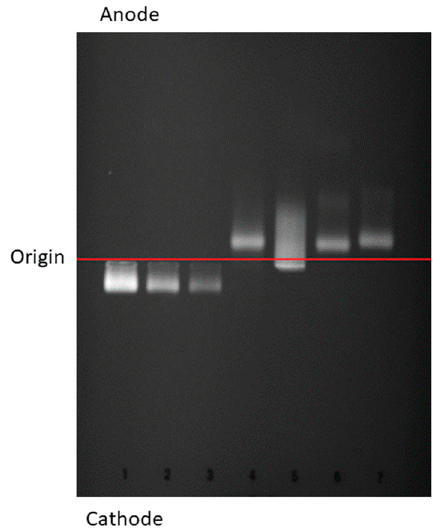
Figure 5. Filipin Staining of synthetic Lp-X and EDTA-plasma after agarose gel electrophoresis. 10 µ L of sequential dilutions of synthetic Lp-X were loaded into lanes 1–3, as follows. 1: 0.530 mg / mL cholesterol; 2: 0.265 mg / mL cholesterol; 3: 0.1325 mg / mL cholesterol. 10 µ L of fresh EDTA-plasma were loaded into lanes 4–7, as follows: 4, FLD patient 2 (without renal disease); 5, FLD patient 3 (with renal disease); 6 and 7, normolipidemic controls. Origin: application